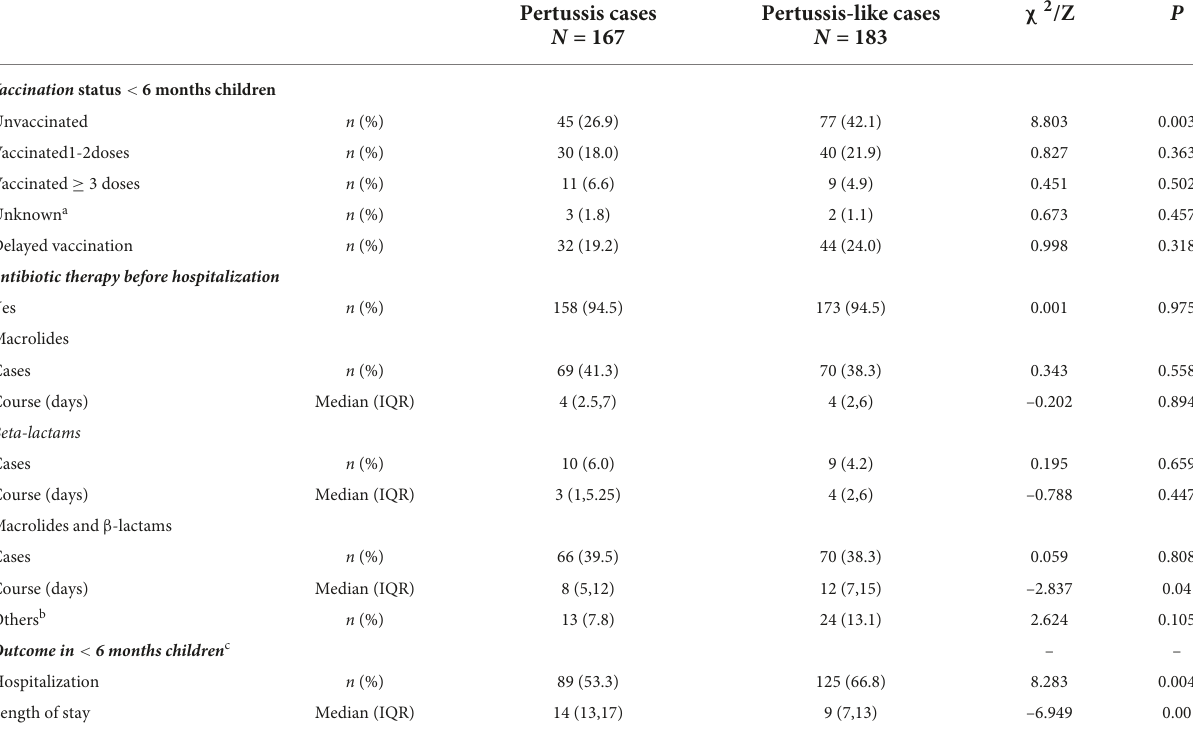
TABLE 2 Vaccination and antibiotic therapy status and clinical outcome of pertussis cases and pertussis-like cases.